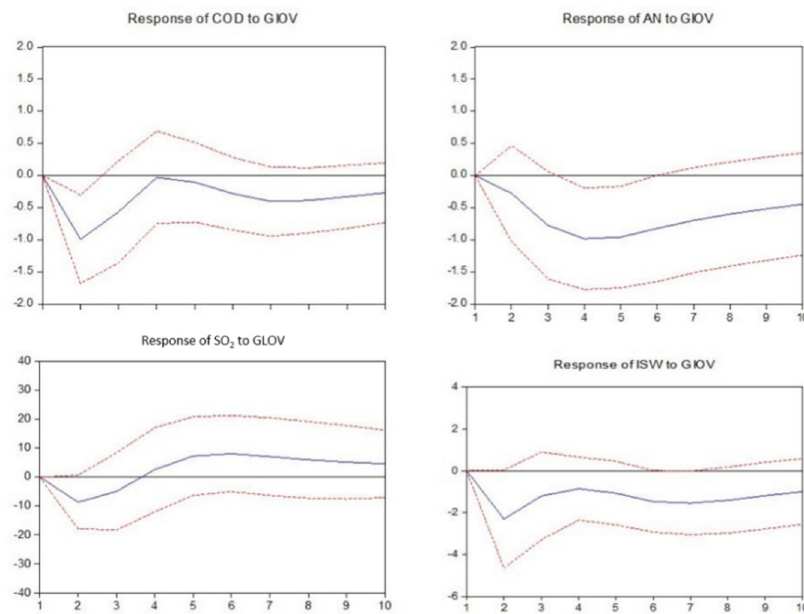
Figure 9. Responses of pollutants charged to industrial output value of extraction of petroleum and natural gas. The solid lines indicate the mean responses to a one standard deviation shock, while the dotted lines represent ± 2 standard deviations of the responses.